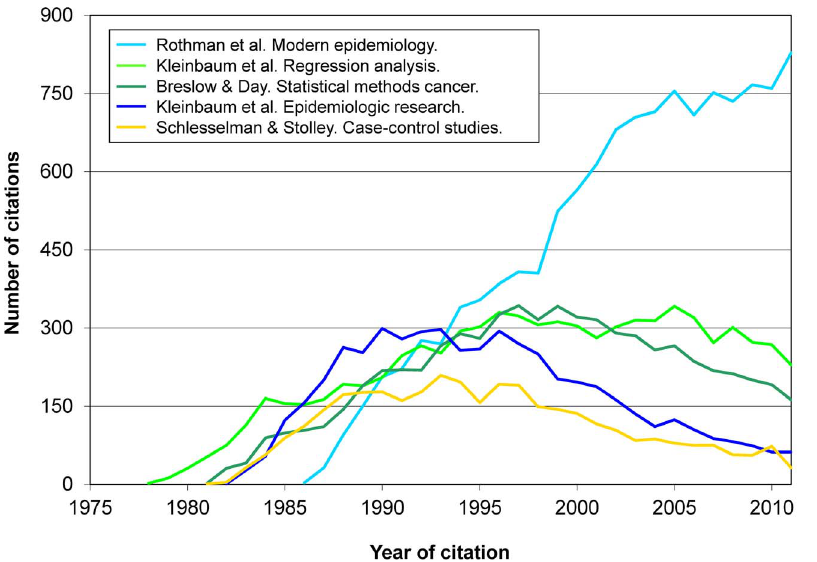
Figure 4. Citations to 6 books on clinical epidemiology (total, 13,272 citations).